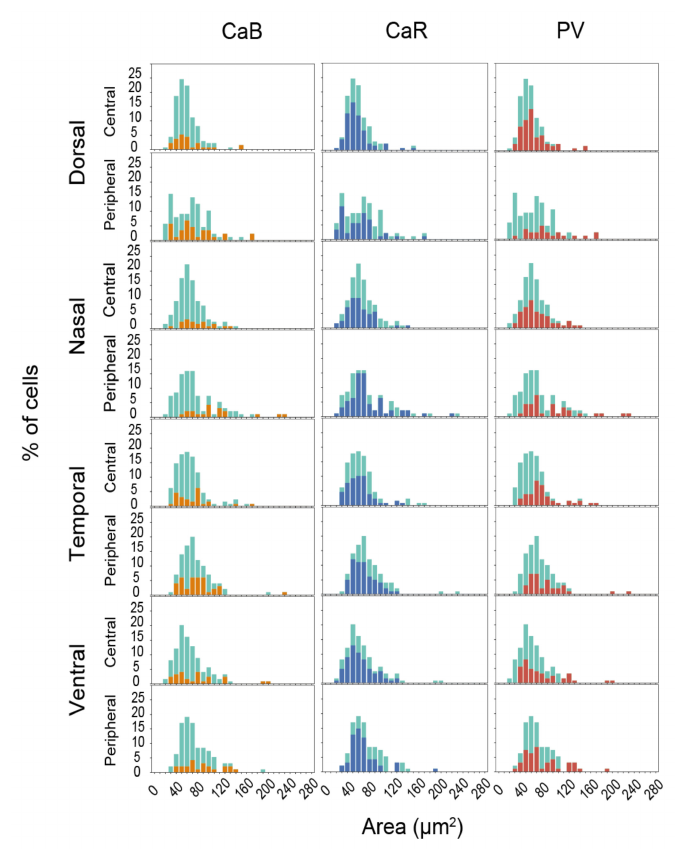
Figure 3. Soma size distribution histograms of CaBP expressing RGCs. The cell size distribution of all RGCs (light blue) and CaBP expressing RGCs (CaB: orange, CaR: blue, PV: red). The bin widths are set at 10 µ m 2 . Note, that only data from quadruple labeling experiments (CaR, CaB, PV, NeuN) were used for this analysis, thus light blue histograms (all cells) are the same across all rows